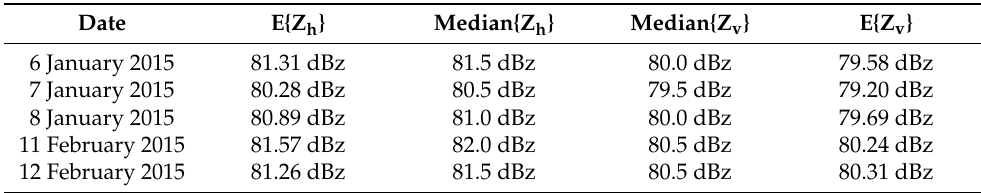
Table 5. Values of two central locations, expected average and median, of the Log-transformed radar reflectivity for the horizontal and vertical polarizations: winter 2015.